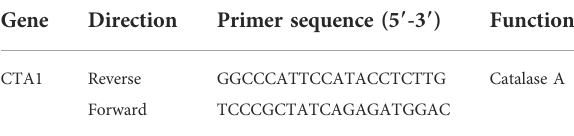
TABLE 1 The target primer set used for RT-qPCR ampli fi cation (Verbelen et al., 2009).